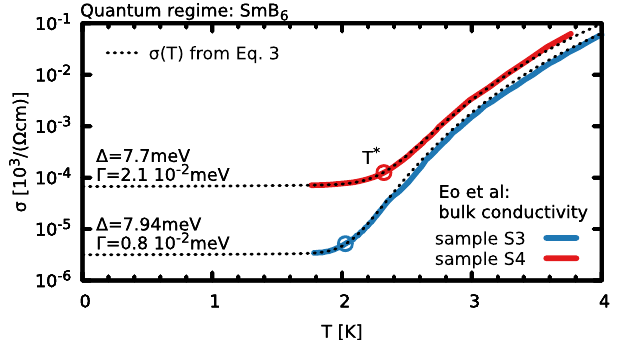
Fig. 6 Bulk conductivity of SmB 6 . Low- T transport in SmB 6 is dominated by surface contributions 11,38 – 40 . With an inverted resistance setup, Eo et al. 11 eliminated the latter and extracted the bulk conductivity, reproduced here for two samples, in order of growing off-stoichiometry: S3, S4. Crucially, bulk conduction still saturates below T * (in fl ection points in ρ ( T ), circles). We fi t the experiment using the phenomenological quantum conductivity Eq. (3). The excellent agreement suggests that the bulk resistivity in SmB 6 is lifetime-limited. Gaps Δ are fi xed to indicated values obtained in ref. 11 T ÞÞ , above 3 K. We extract a scattering from activation laws, exp ð Δ = ð 2 k B rate Γ that increases by more than two-fold for an off-stoichiometry that almost doubles from S3 to S4 11 . For cleaner samples S1 and S2, experimental noise is large and T * moves outside the measured temperature window, see Supplementary Fig. S3. From all samples combined, we extract: T * ∝ Γ 1/8 valence character. Still, the probability of fi nding the system in a 4 f 1 - state with J = 5/2 merely decreases quantitatively from 80% ( P = 0) to ~55% ( P = 40GPa) — excluding a dominantly valence-driven metallization. (3) Instead, we unravel the non-monotonic transport to originate from two counter-acting structural trends within the (cid:1) con fi nes of spacegroup I 43 d : globally, pressure shrinks the lattice, enhancing hybridization gaps. While the atomic coordinates of Ce and Pt are dictated by symmetry, the local Bi position ( u , u , u ) may vary. Minimizing total energies, we fi nd u = 0.088 at P = 0 — in agreement with the experimental u = 0.086 29 — and predict a much larger u = 0.097 at P = 40GPa (Supplementary Fig. S2). This see- mingly minute modi fi cation drastically changes inter-atomic hybri- dizations: instead of a monotonic increase (realized for u = const), a critical pressure emerges above which the gap decreases. Hence, Ce 3 Bi 4 Pt 3 exhibits a peculiar high-pressure behavior, not canonical for Kondo insulators in general.